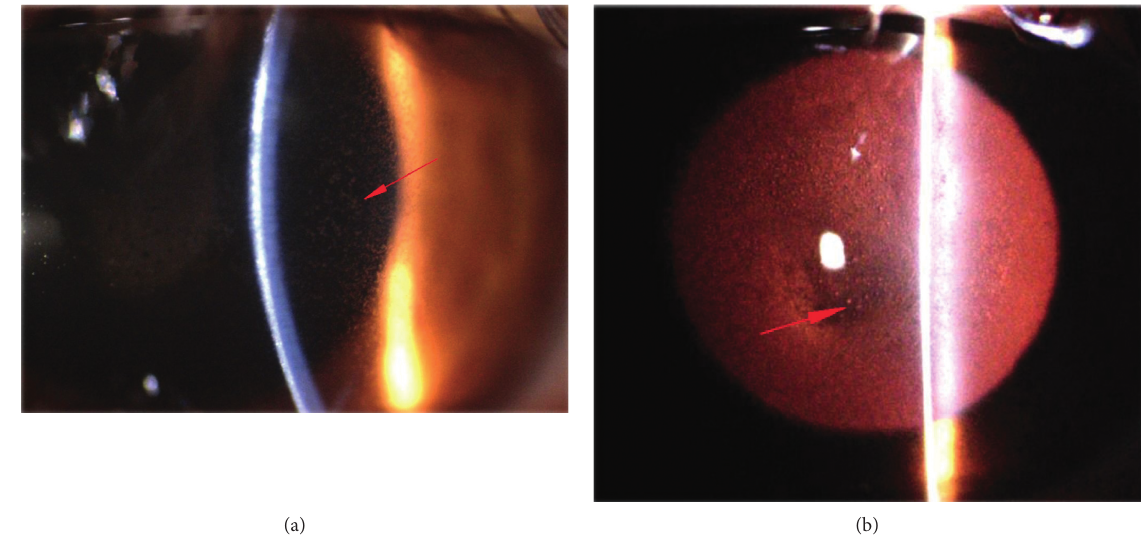
Figure 1: Photography of the anterior segment of the eye. (a) Numerous microcysts visible in the epithelial layer (red arrow) (mag. 16x). (b) Epithelial microcysts visible in retroillumination (red arrow) (mag.